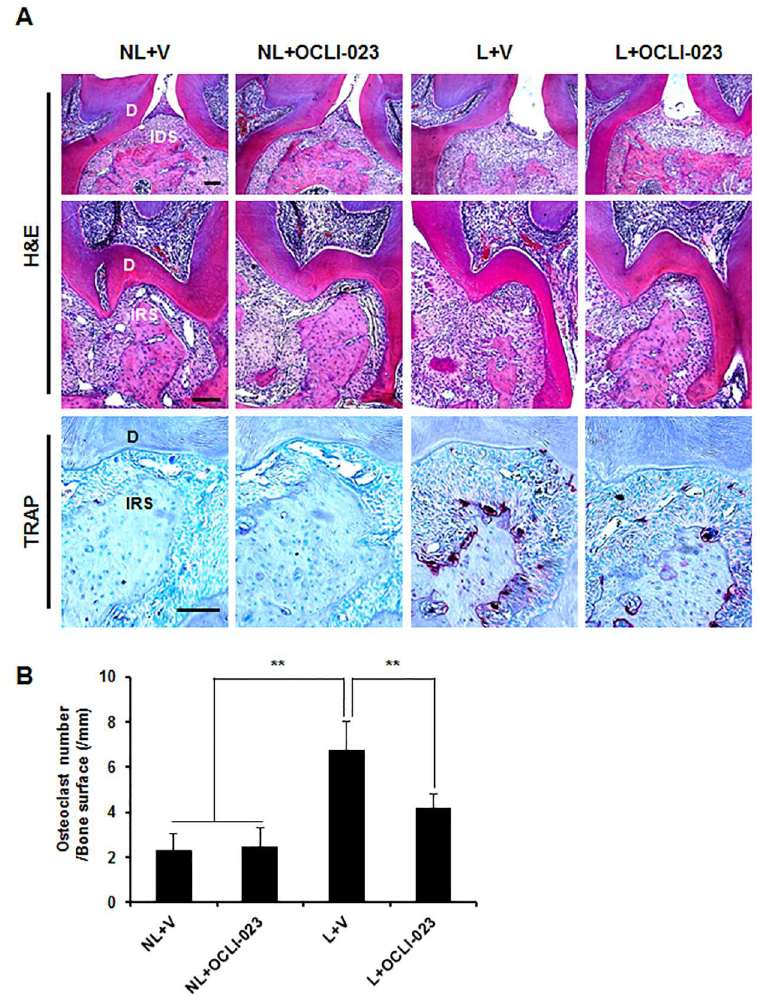
Fig 5. Histological analysis of alveolar bones in an experimental periodontitis model. (A) Both nonligated and ligated mice were injectedwith either vehicleor OCLI-023 as describedin Fig 4. The fixed maxillaewere decalcified, sectioned, and stained with H&E (upper and middle)and with TRAP (lower). Scale bars, 100 μ m. P, pulp; D, dentin; IDS, interdental septum of the alveolarprocess; IRS, interradicular septum of the alveolarprocess. (B) The osteoclast numberper bonesurface was assessed. n = 5 in each group. ** p < 0.01 versus the ligated,